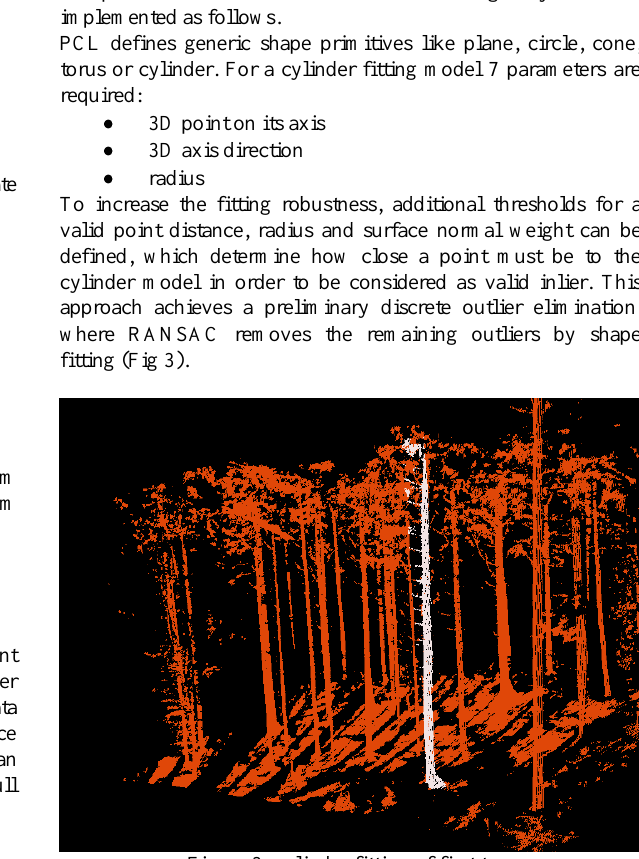
Figure 3. cylinder fitting of first